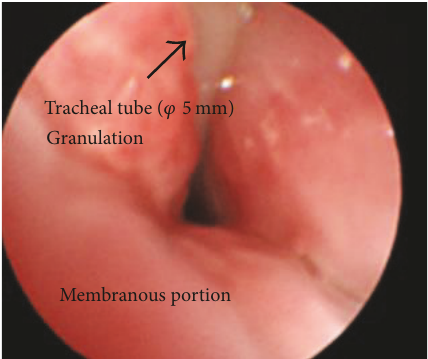
Figure 1: Bronchoscopy showed a stenosed airway. This view was obtained by insertion of the bronchoscope through the nasal cavity.